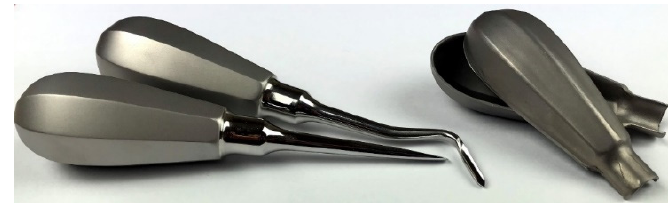
Figure 1. View of handle parts of surgical instruments.